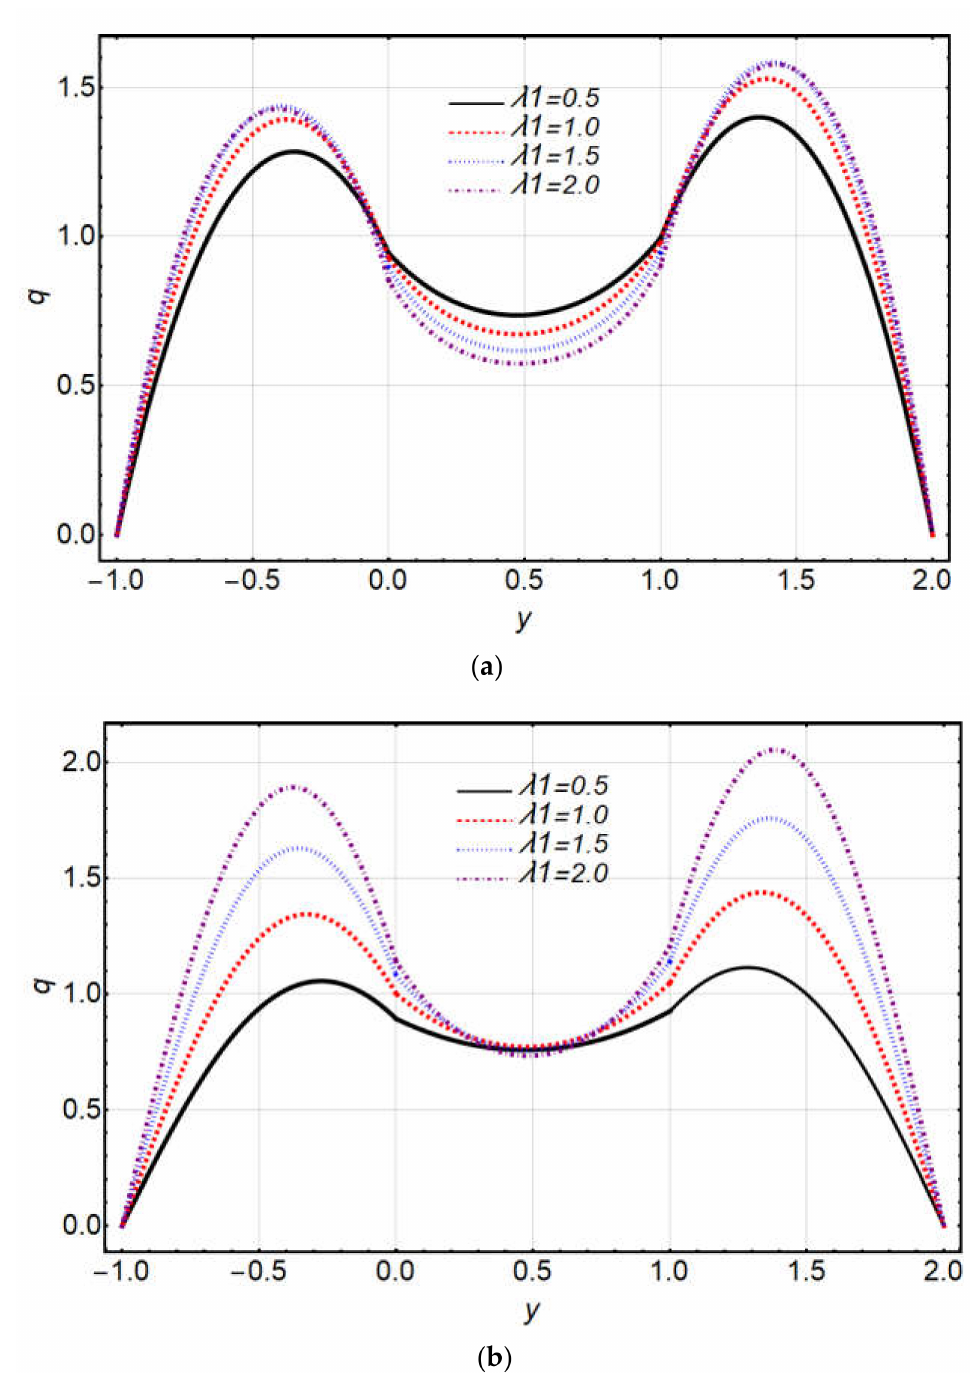
Figure 7. Velocity distribution of λ 1 : ( a ) axial, ( b )